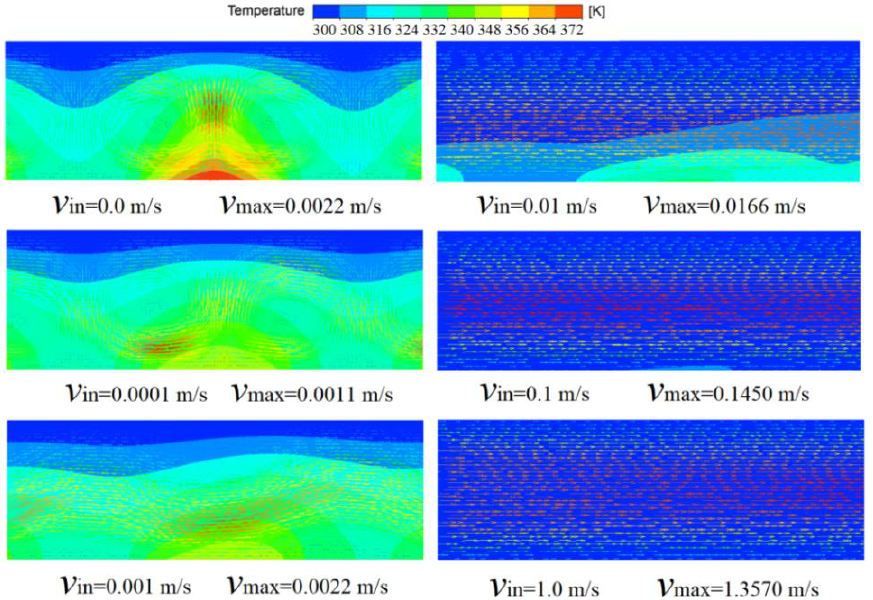
Figure 7. The heat transfer coefficients for various Rayleigh numbers 10 3 ,10 4 and 10 5 , and mass frac- tions 0–4 wt%.